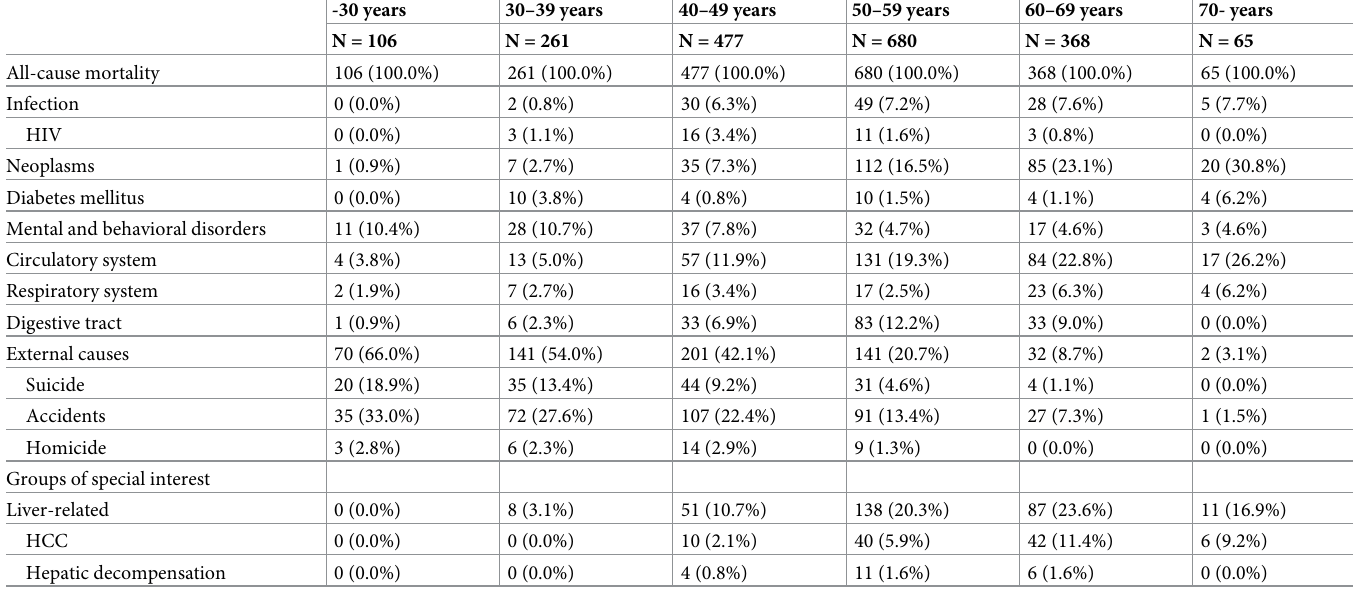
Table 4. Proportions of deaths by age among amphetamine